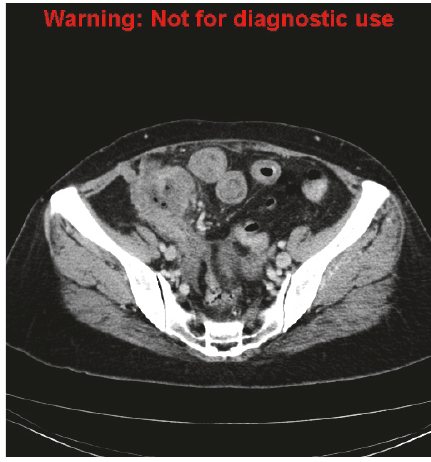
Figure 6: A persistent periappendiceal collection is again seen. New findings include small bowel obstruction as well as nodules adjacent to the collection and along the track of previous drain